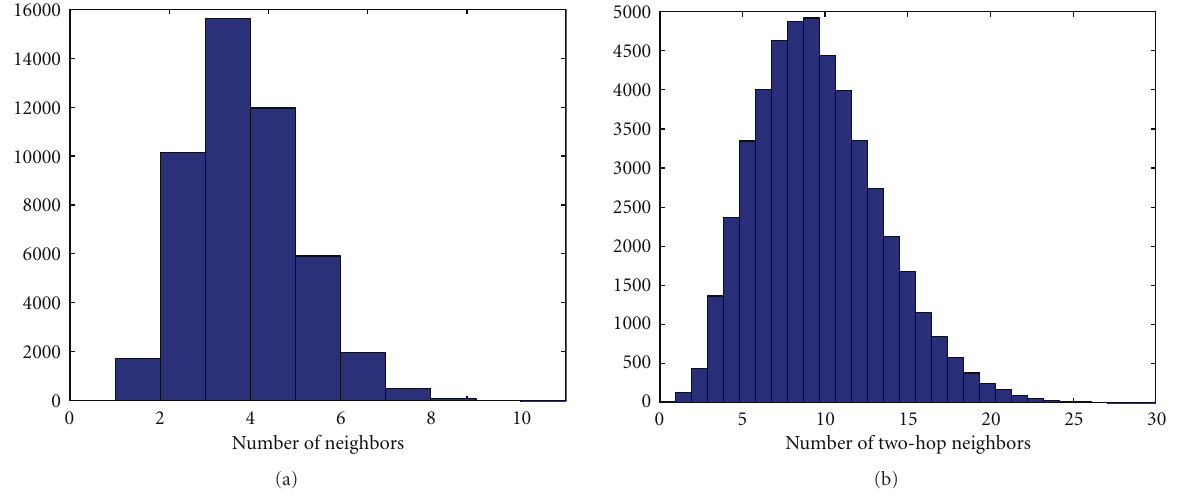
Figure 2: The distribution of the number of neighbors (a) and the number of two-hop neighbors